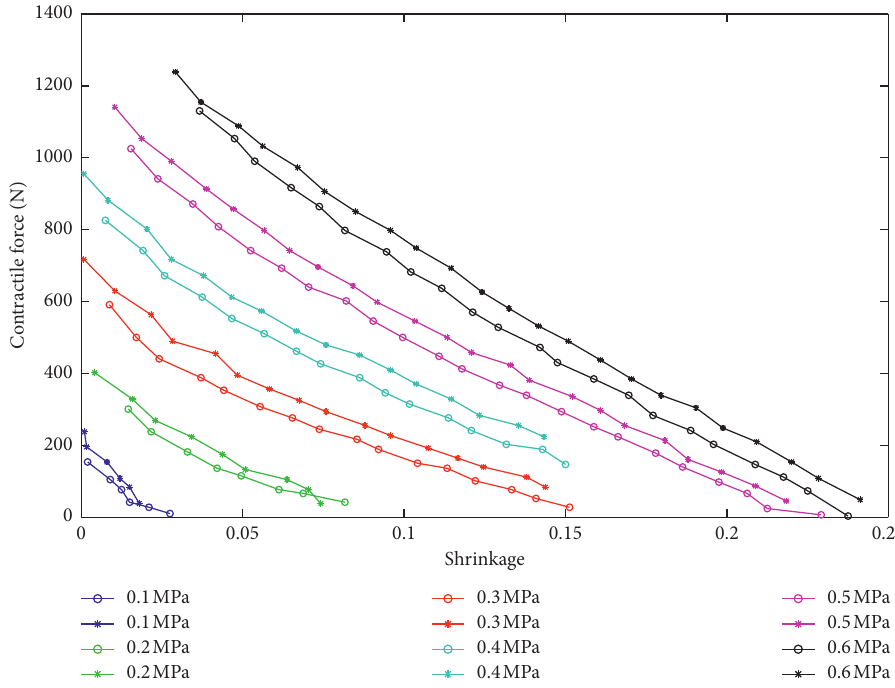
Figure 7: The relation of contractile force and shrinkage under the condition of equal pressure. Table 1: The estimated value of the parameter with the PAM shrinking.